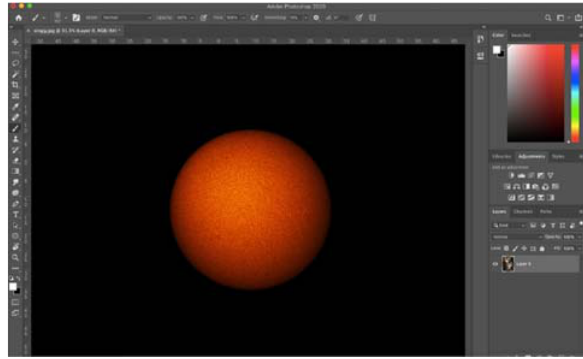
Figure 11. Colouring a H-Alpha image in Adobe